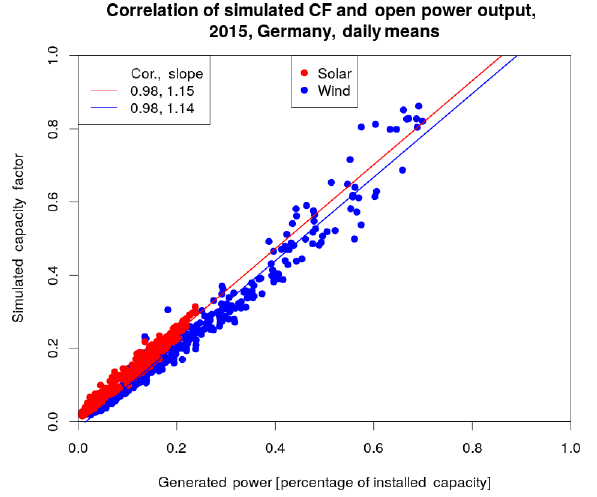
Figure 1. Scatterplot of daily means of simulated and actually gen- erated wind and photovoltaic power for Germany, 2015; Generated power data is taken from the Open Power System Data